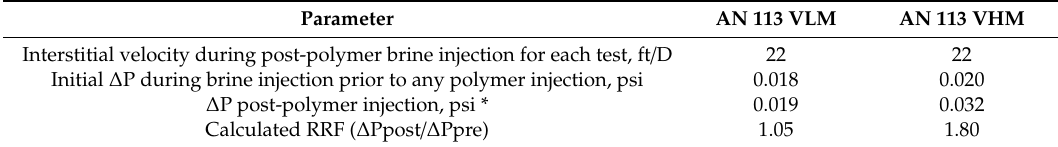
Table 5. Residual Resistance Factor for AN 113 VLM and AN 113 VHM.